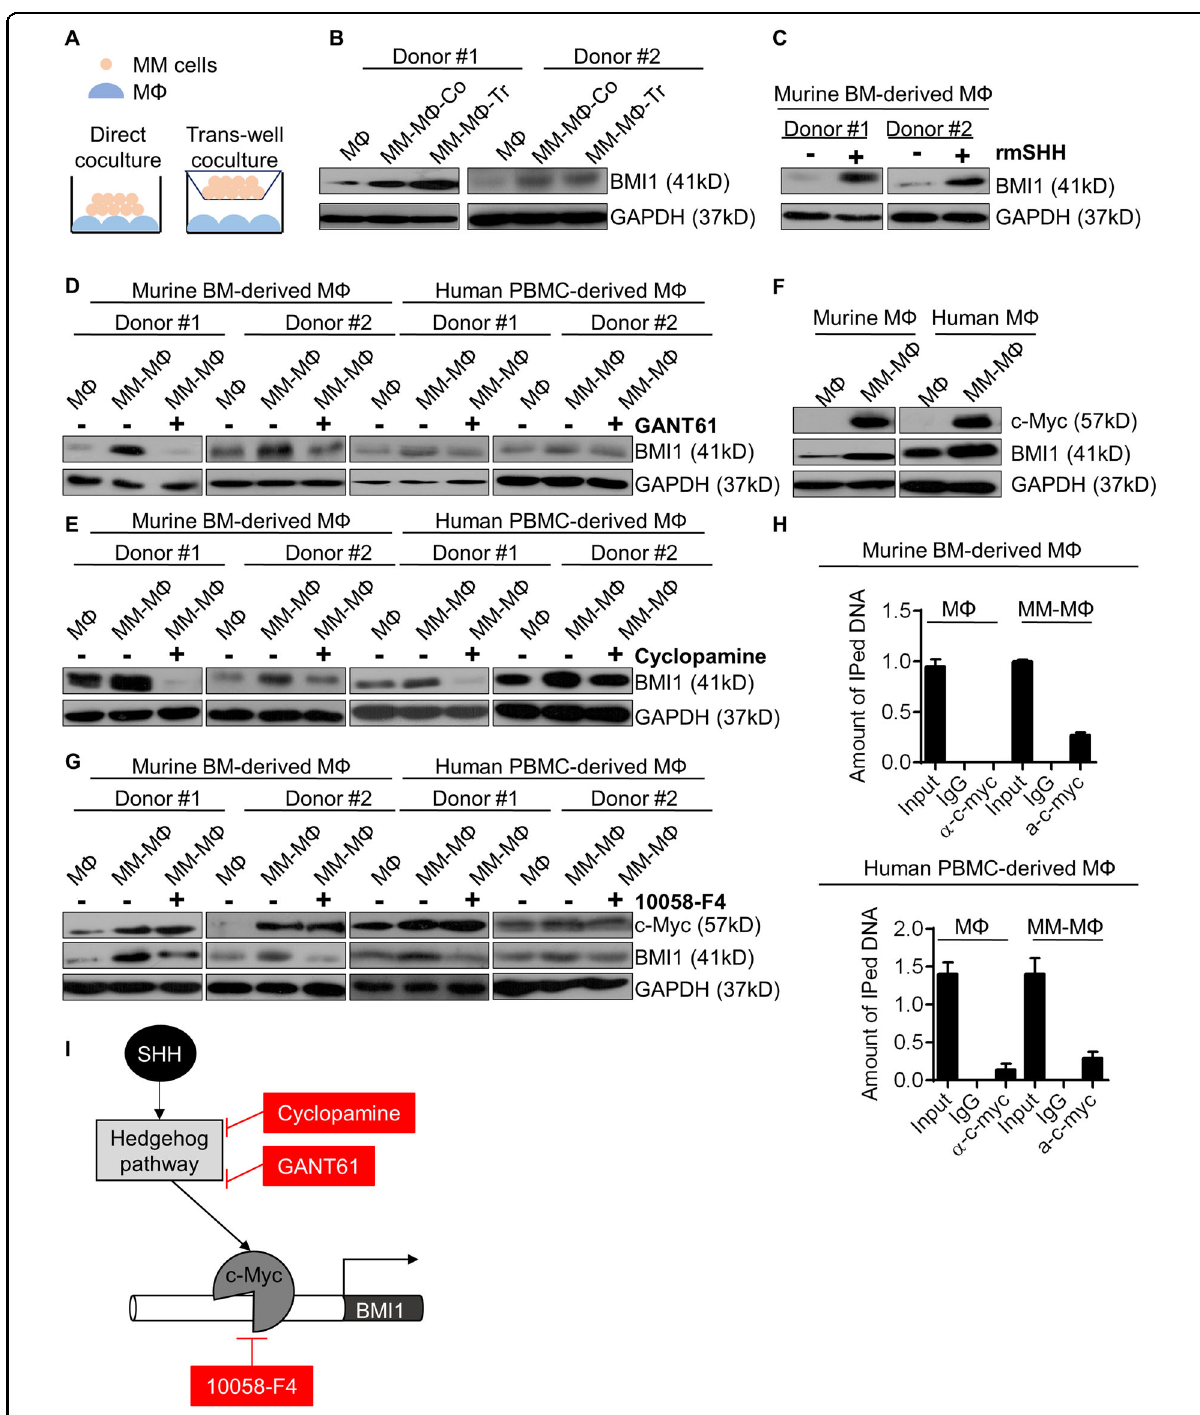
Fig. 3 Hedgehog-Myc axis regulates BMI1 overexpression in MM-M Φ s. A Illustration of direct and trans-well co-culture of M Φ s and MM cells. B Western blot showed in both direct and trans-well co-culture methods, the expression of BMI1 was elevated in MM-M Φ s, relative to M Φ s. C Western blot showed that protein levels of BMI1 were increased in M Φ s upon rmSHH treatment. D Western blot showed that the GLI1/GLI2 transcriptional activity inhibitor GANT61 suppressed expression of BMI1 in both murine BM-derived and human PBMC-derived MM-M Φ s. E Western blot showed that the Smo antagonist Cyclopamine reduced expression of BMI1 in both murine BM-derived and human PBMC-derived MM-M Φ s. F Western blot showed c-Myc expression was increased in both murine and human derived MM-M Φ s. G Western blot showed that the c-Myc inhibitor 10058-F4 reduced expression of BMI1 in both murine and human MM-M Φ s. H ChIP-qPCR showed the relative occupancy of c-Myc and IgG control to BMI1 promoter region in M Φ s and MM-M Φ s derived from mouse and human. I Schematic of Hedgehog-c-Myc axis regulates BMI1 expression in MM-M Φ